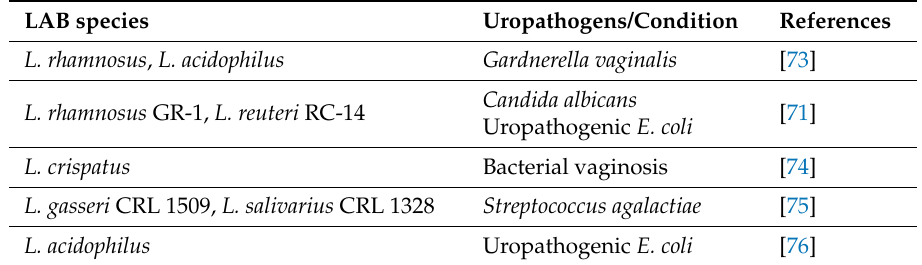
Table 3. In vivo and clinical studies of antimicrobial activities of LAB isolates against